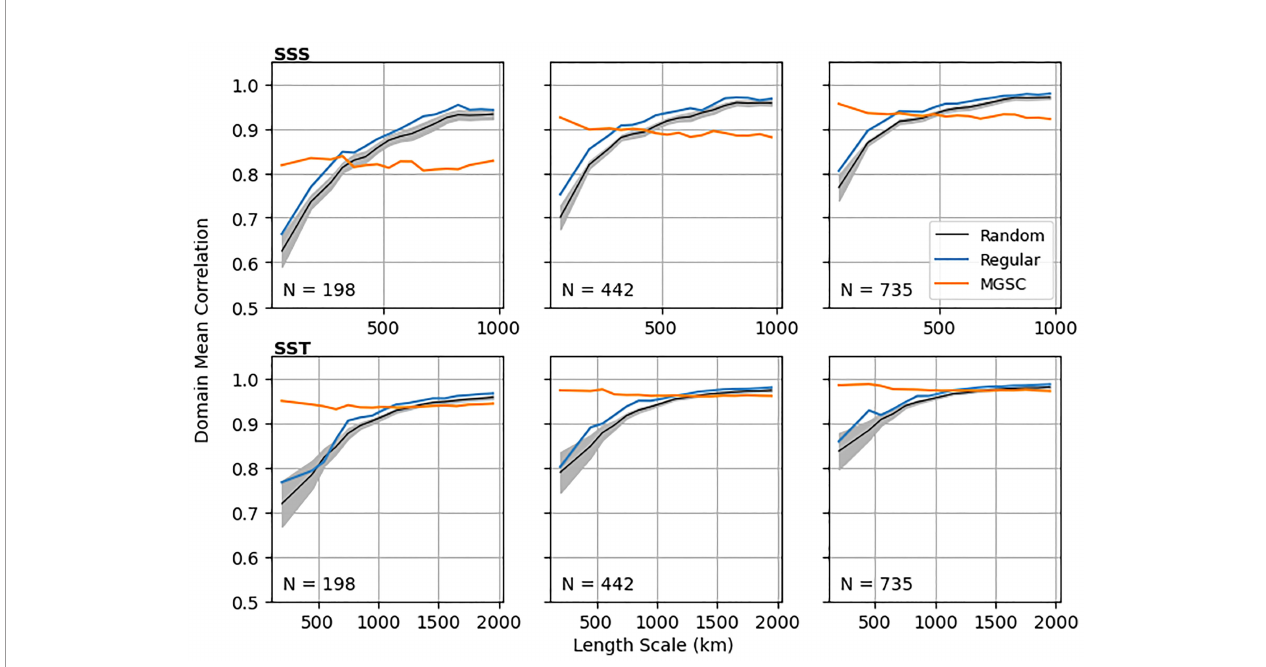
FIGURE 8 | Area mean correlations resulting from a 10 year data construction using simple linear regression. Means are calculated in length scale bins. Three different numbers of observations are considered (columns): N=198, 442 and 735. These values match up with the numbers of points in three different regular observation grids. For the random placements, lines show the ensemble mean and the shaded areas show 1 standard deviation either side of the